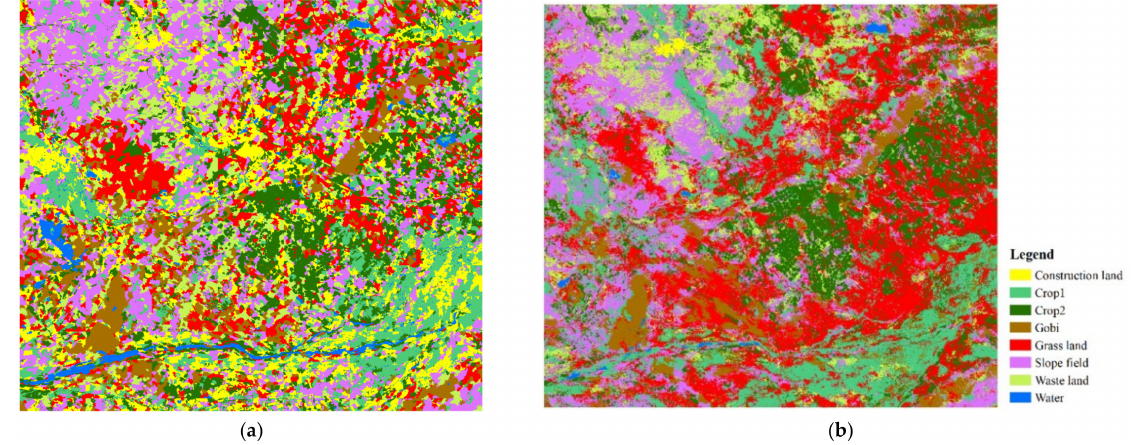
Figure 10. Fusion result of the ESTARFM method with Landsat–MODIS pairs of date 4 January 2018 and 12 May 2018 as input and to predict on date 10 June 2017, 28 July 2017, 29 August 2017, 5 February 2018, 25 March 2018, 3 October 2018, 19 October 2018 and 6 December 2018.